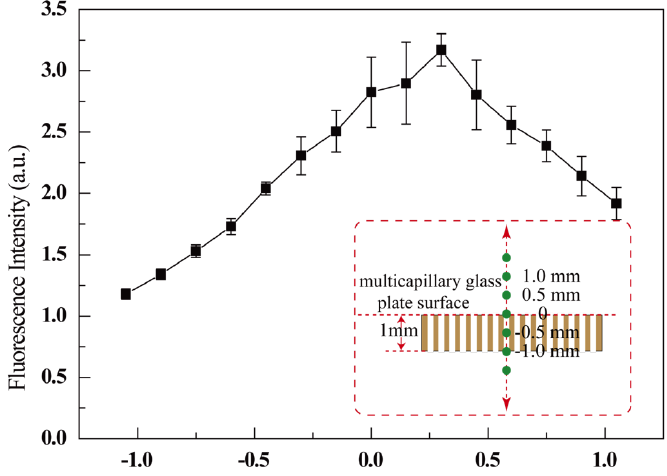
Figure 2. The effect of laser focusing point for fluorescence detection in the microwell was investigated by measuring a Resorufin solution (50 μmol/L). The inserted schema illustrated focusing point moving up and down vertically to the surface of the